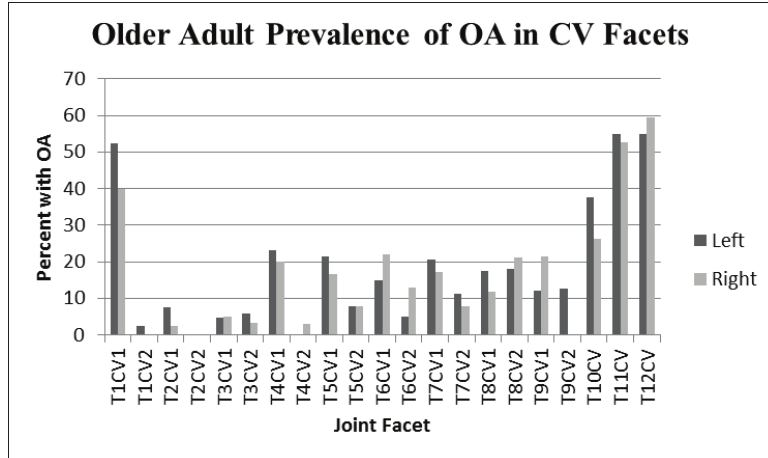
Figure 3: Prevalence of OA in CV joints in older